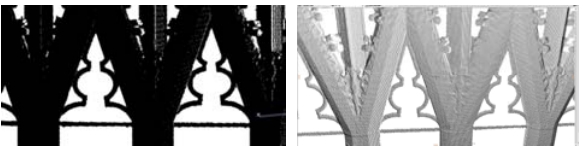
Table 4. Summary of point cloud’s import process in Revit.